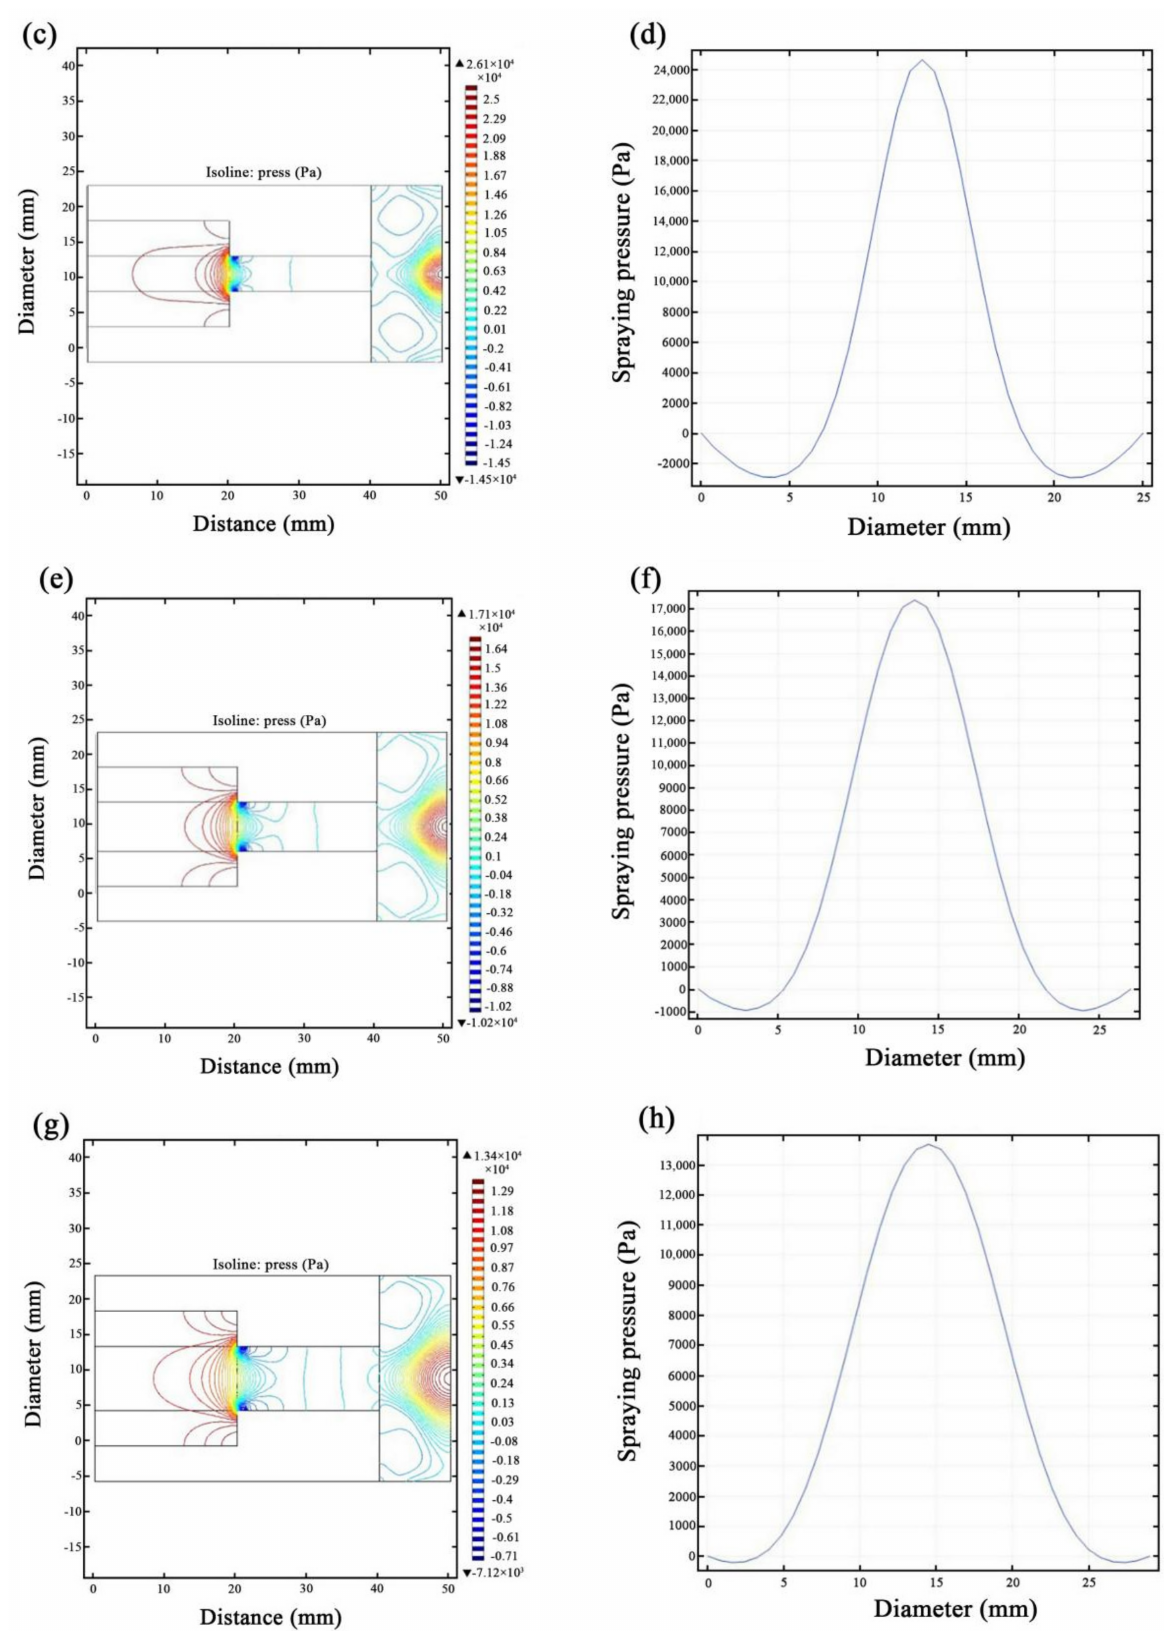
Figure 3. Simulation diagram of the spraying pressure of the electrolyte for preparing Ni–TiN coatings: ( a , b ) Nf = Φ 3 mm, ( c , d ) Nf = Φ 5 mm, ( e , f ) Nf = Φ 7 mm, ( g , h ) Nf = Φ 9